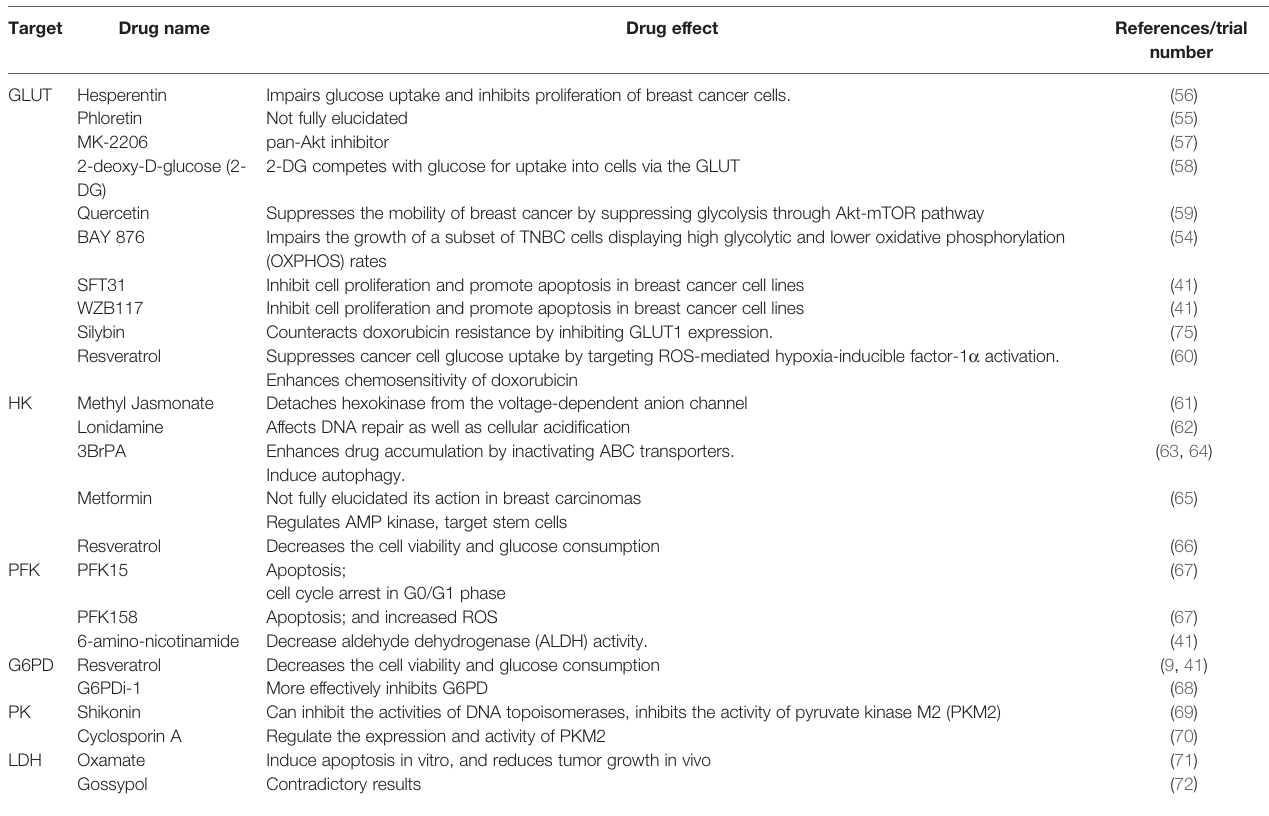
TABLE 2 | Non-exhaustive list of drugs targeting glucose